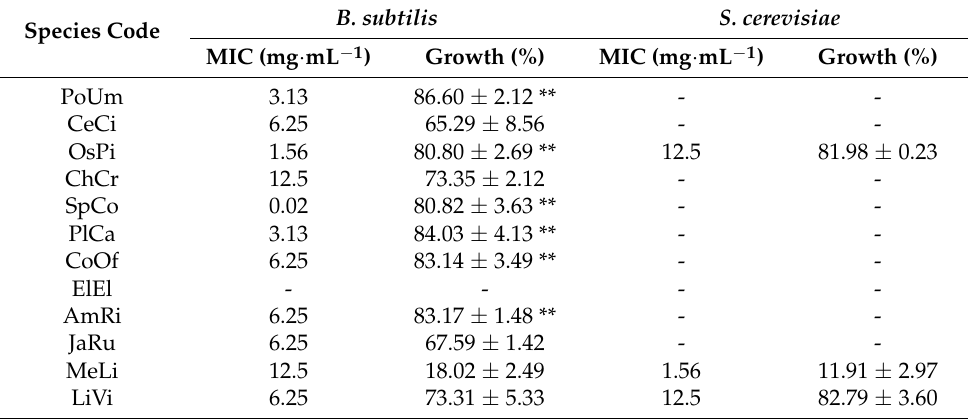
Table 2. Minimum Inhibitory Concentration (MIC) and respective extract concentrations for twelve red seaweed species, assessed against Bacillus subtilis and Saccharomyces cerevisiae . PoUm: Por- phyra umbilicalis , CeCi: Ceramium ciliatum , OsPi: Osmundea pinnatifida , ChCr: Chondrus crispus , SpCo: Sphaerococcus coronopifolius , PlCa: Plocamium cartilagineum , CoOf: Corallina officinalis , ElEl: Elisolandia elongata , AmRi: Amphiroa rigida , JaRu: Jania rubens , MeLi: Mesophyllum lichenoides , LiVi: Liagora viscida . Values are presented as means ± SD ( n = 4), or (-) whenever all the concentrations tested yielded more than 100% bacterial growth. Asterisks (**) indicate statistically highly significant differences between the species with the lowest bacterial growth (MeLi) and all other remaining species ( B. subtilis : Kruskal–Wallis test ( χ 2 (10) = 31.670; p = 0.000)). B. subtilis S. cerevisiae Species Code MIC (mg · mL − 1